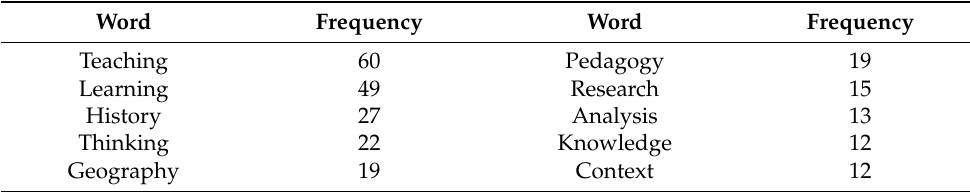
Table 2. Words that best relate to the idea of didactics in the social sciences.